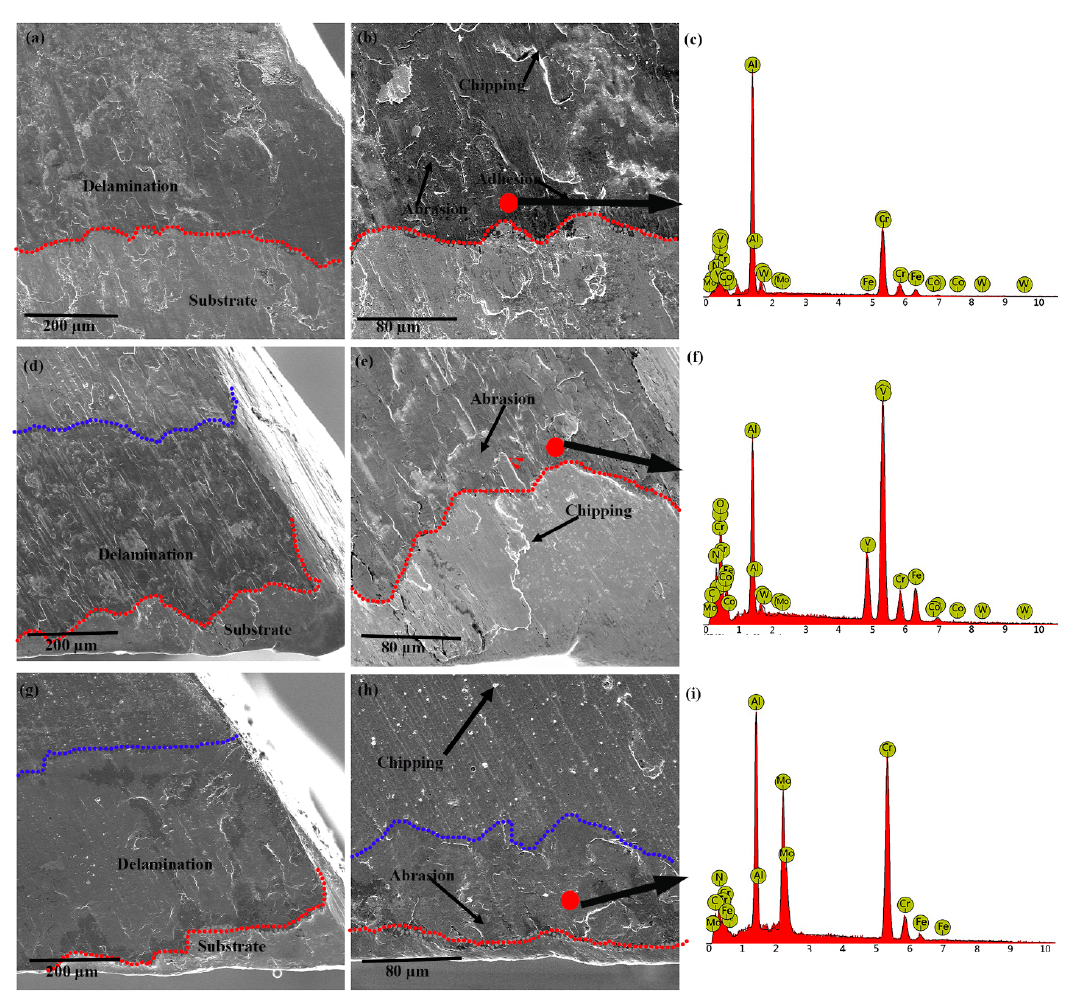
Figure 8. Worn micrographs on flank surfaces of the coated HSS straight shank end milling cutter under the 90 m/min speed: ( a ), ( b ), and ( c ) AlCrN coating; ( d ), ( e ) and ( f ) AlCrMoN coating; ( g ), ( h ), and ( i ) AlCrVN coating.